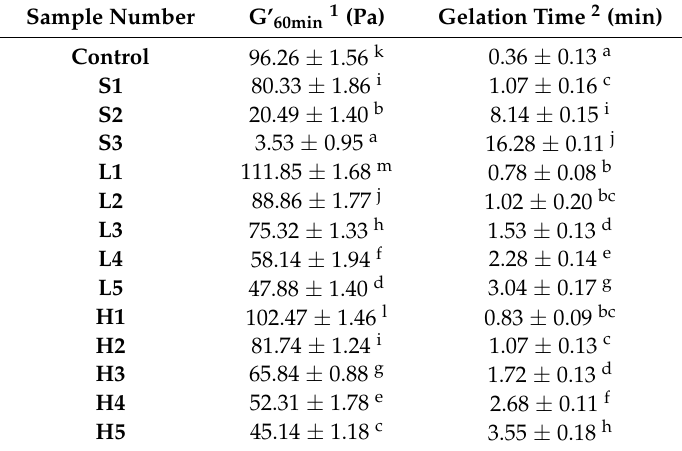
Table 1. The rheological parameters of mixtures during renneting.